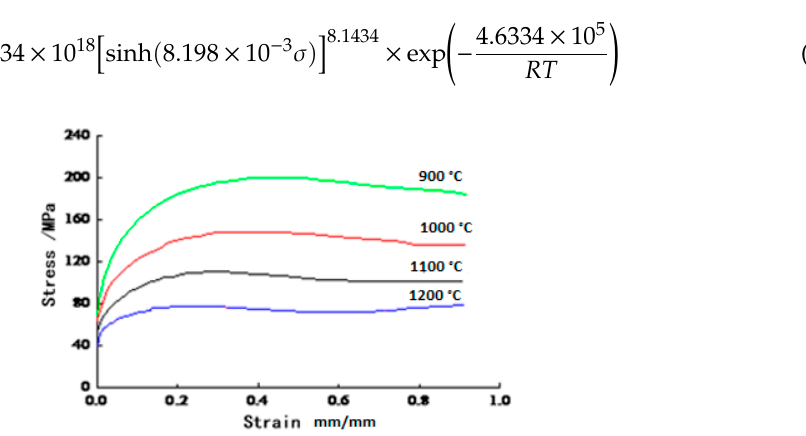
Figure 4. True stress-strain curves of 42CrMo at different temperatures at the strain rate of 0.01 s − 1 . In the formula, R is the gas constant, which is 8.31 J / (K · mol); T is the deformation temperature. The critical strain of dynamic recrystallization can be estimated from the peak strain of the stress-strain curve. Dynamic recrystallization (DRX) occurs before the stress reaches the peak. When the stress reaches the peak stress, the corresponding strain can reflect the deformation state of the